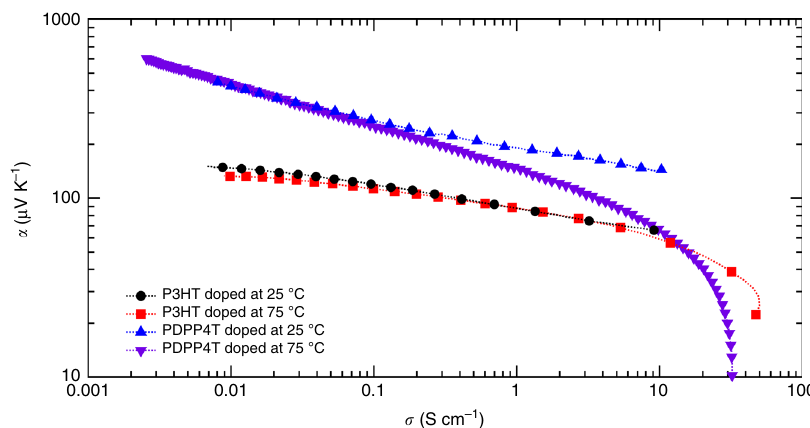
Fig. 3 Seebeck coef fi cient vs. conductivity plot. A log-log plot of Seebeck coef fi cient vs. conductivity for poly(3-hexylthiophene) (P3HT) doped at 25 °C (black circles), P3HT doped at 75 °C (red squares), poly[2,5-bis(2-octyldodecyl)pyrrolo[3,4-c]pyrrole-1,4(2H,5H)-dione-3,6-diyl)-alt-(2,2 ′ ;5 ′ ,2 ′′ ;5 ′′ ,2 ′′ ′ -quaterthiophen-5,5 ′′′ -diyl)] (PDPP4T) doped at 25 °C (blue up triangles), and PDPP4T doped at 75 °C (purple down triangles). One of every fi ve data points collected is plotted along with a dashed line as a visual guide NATURE COMMUNICATIONS| (2019) 10:2827